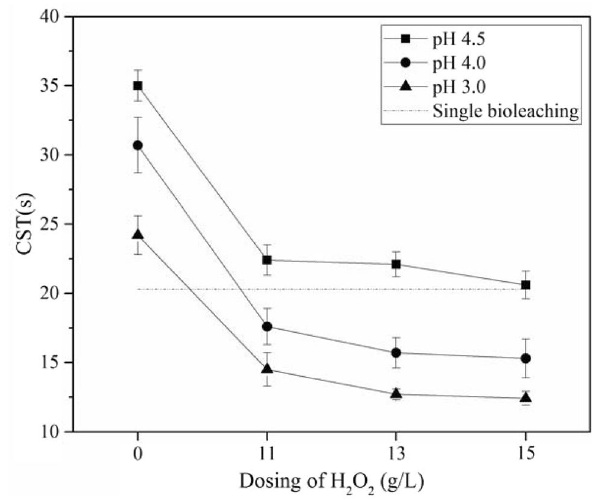
Figure 6. Changes of CST under different H 2 O 2 dosage and